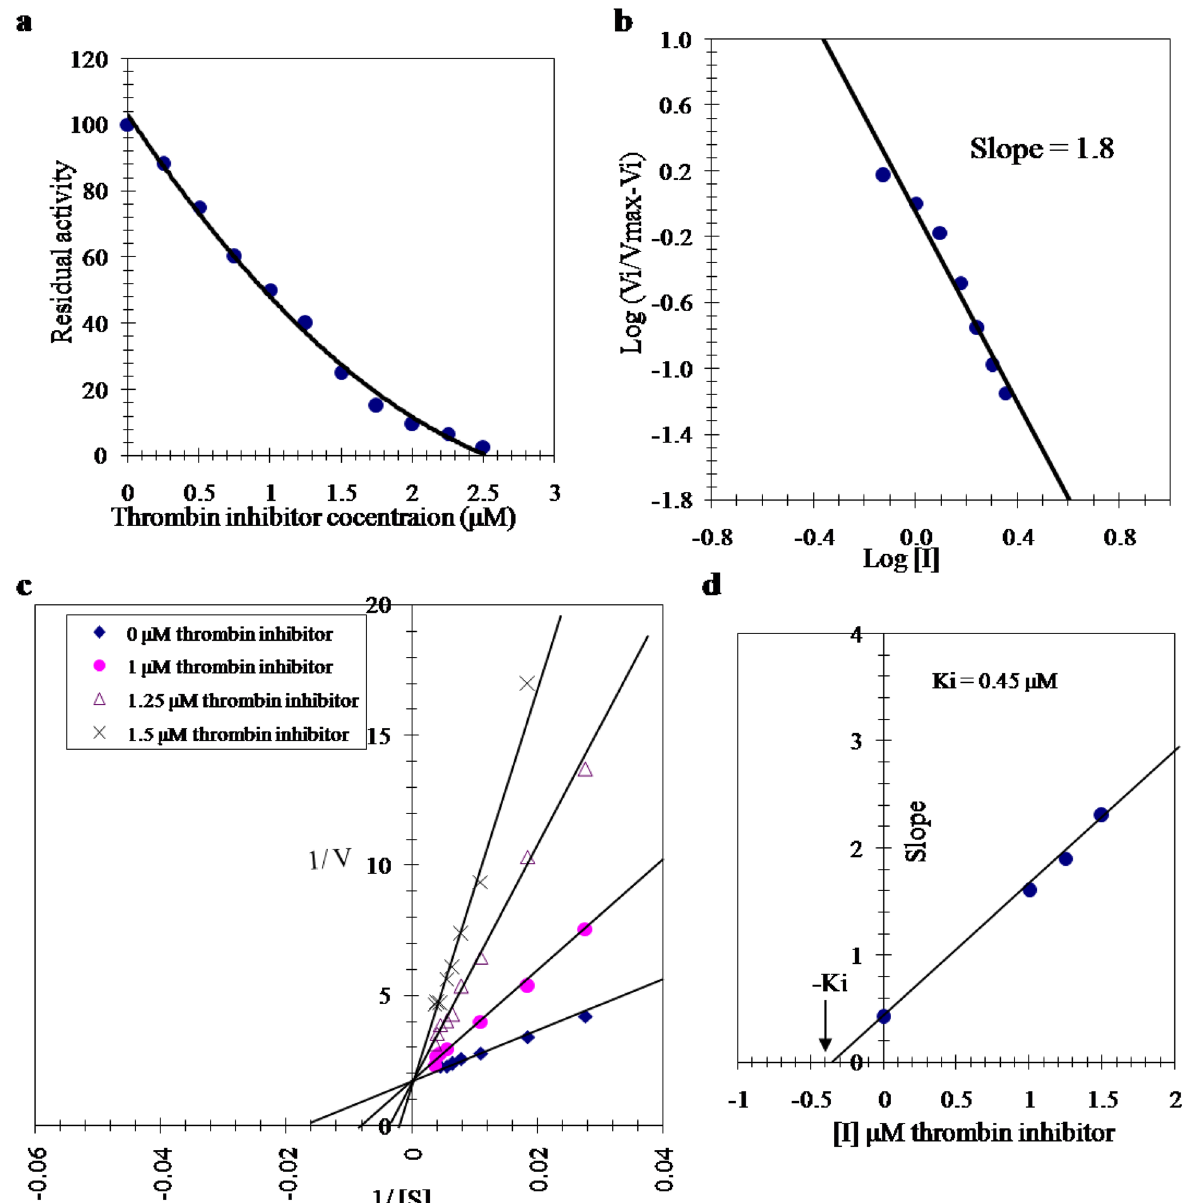
Fig. 4 a The effect of varying concentrations of the camel tick salivary gland thrombin inhibitor on the activity of camel thrombin. b Hill plot for the inhibition of the activity of camel thrombin by increasing concentrations of the camel tick salivary gland thrombin inhibitor. c Lineweaver–Burk plots showing the type of inhibition of the camel thrombin by the camel tick salivary gland thrombin inhibitor. The activity of a constant amount of camel thrombin was measured with varying concentrations of the substrate N-p-Tosyl-Gly-Pro-Arg-p-nitroanilide acetate in the absence and presence of three various concentrations of salivary gland thrombin inhibitor. d Determination of the inhibition constant (Ki) value for inhibition of camel thrombin activity by the camel tick salivary gland thrombin inhibitor. The plotted slope values were determined from the lines of reciprocal plots of the different inhibitor